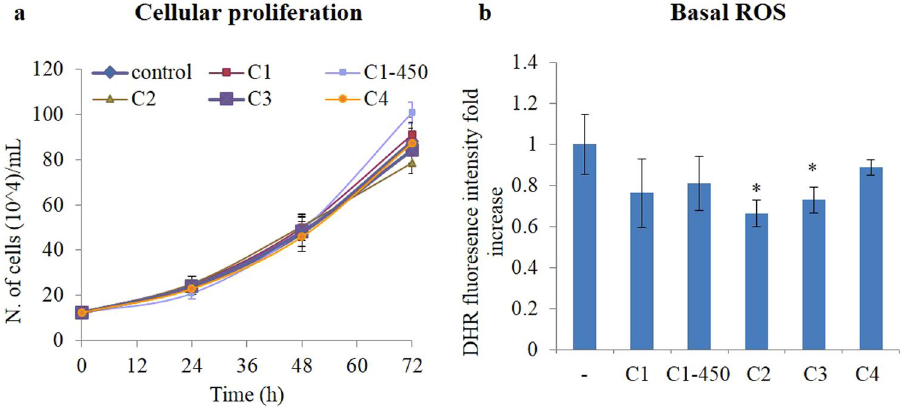
Figure 6. CNP nanoparticles do not show any toxicity. ( a ) Time course of cellular proliferation for 12–72 h measured by cells counting reported as number of cells. ( b ) Basal ROS levels measured by DHR fluorescent signal detected by flow cytometry 24 h after cell treatment with CNPs (200 μ g/mL). Values are the mean of ≥ 3 independent experiments ± SD; * p < 0.05 (ANOVA). Significance with respect to the control group is